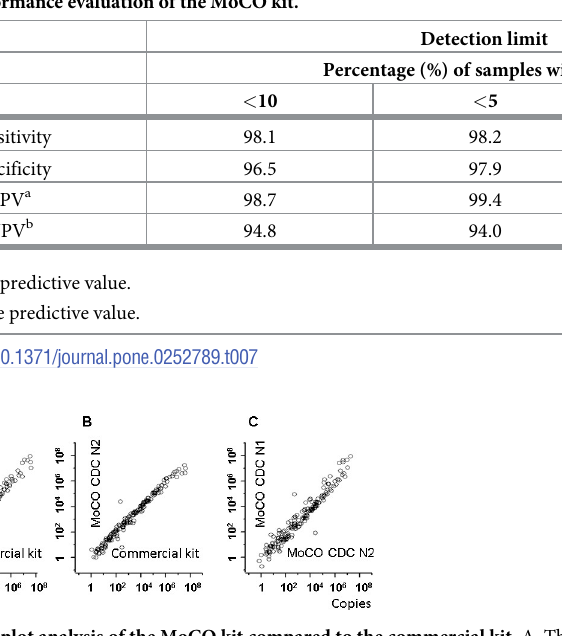
Fig 3. Log-log plot analysis of the MoCO kit compared to the commercial kit. A. The MoCO kit with the CDC N1 primers and probe set was compared to the Takara Kit with the CDC N1 and N2 primers and probes. B. The MoCO kit with the CDC N2 primers and probe set was compared to the Takara Kit with the CDC N1 and N2 primers and probes. C. The MoCO kit with the CDC N1 primers and probe set was compared to the MoCO kit with the CDC N2 primers and probe set (n = 213).